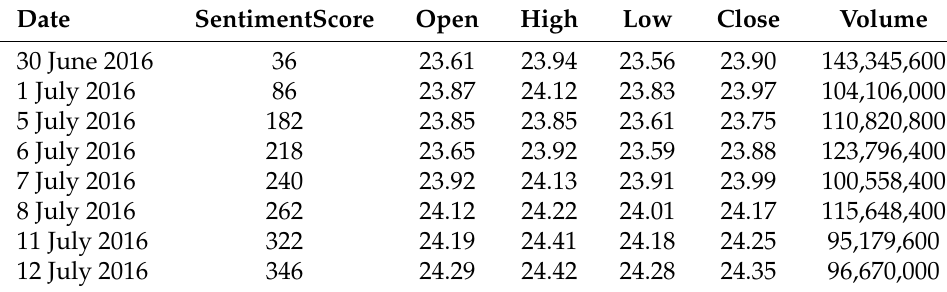
Table 3. A view of sentiment data for stock price movement